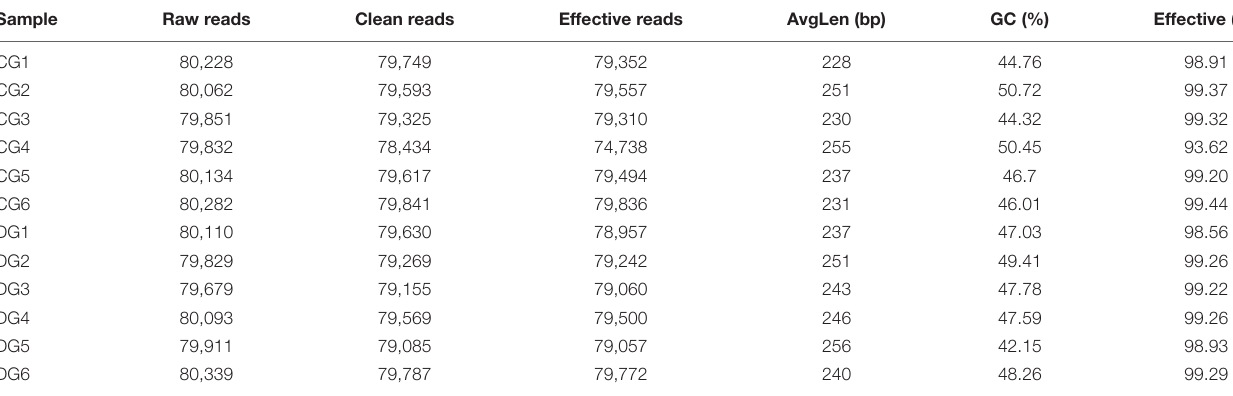
TABLE 2 | The fungal sequence information of each sample.